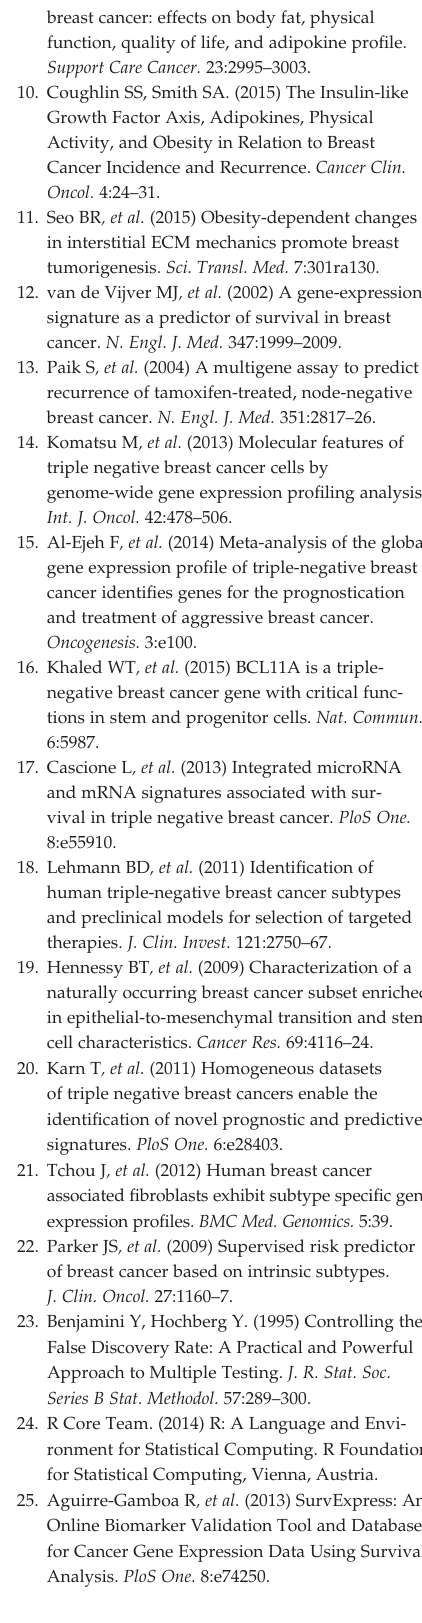
breast cancer: effects on body fat, physical function, quality of life, and adipokine profile. Support Care Cancer.